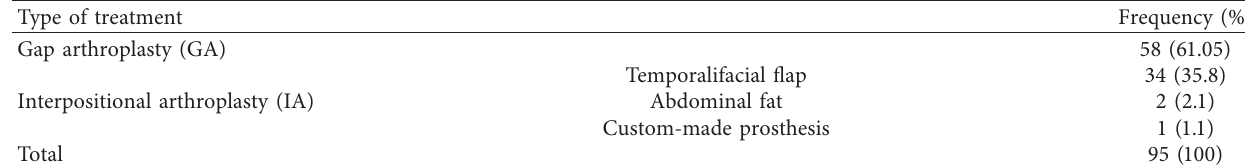
Table 5: Frequency distribution of surgical treatments used in the management of patients. Type of